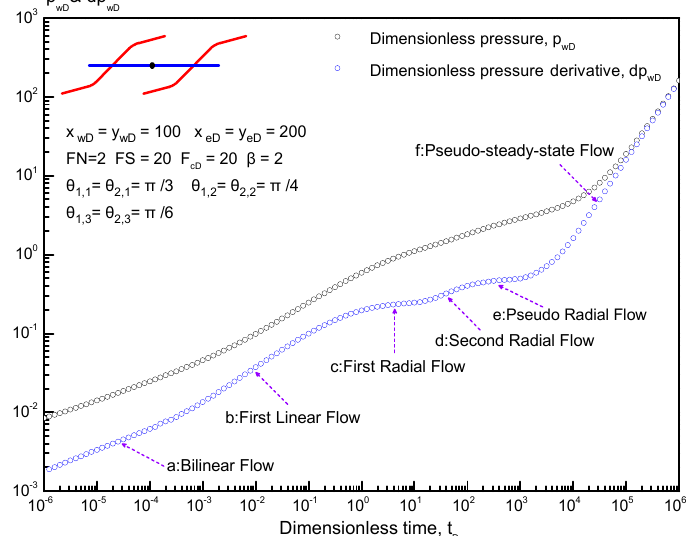
Figure 6. Typical curves of the pressure and pressure derivative for a horizontal well interpreted by two reorientation fractures.